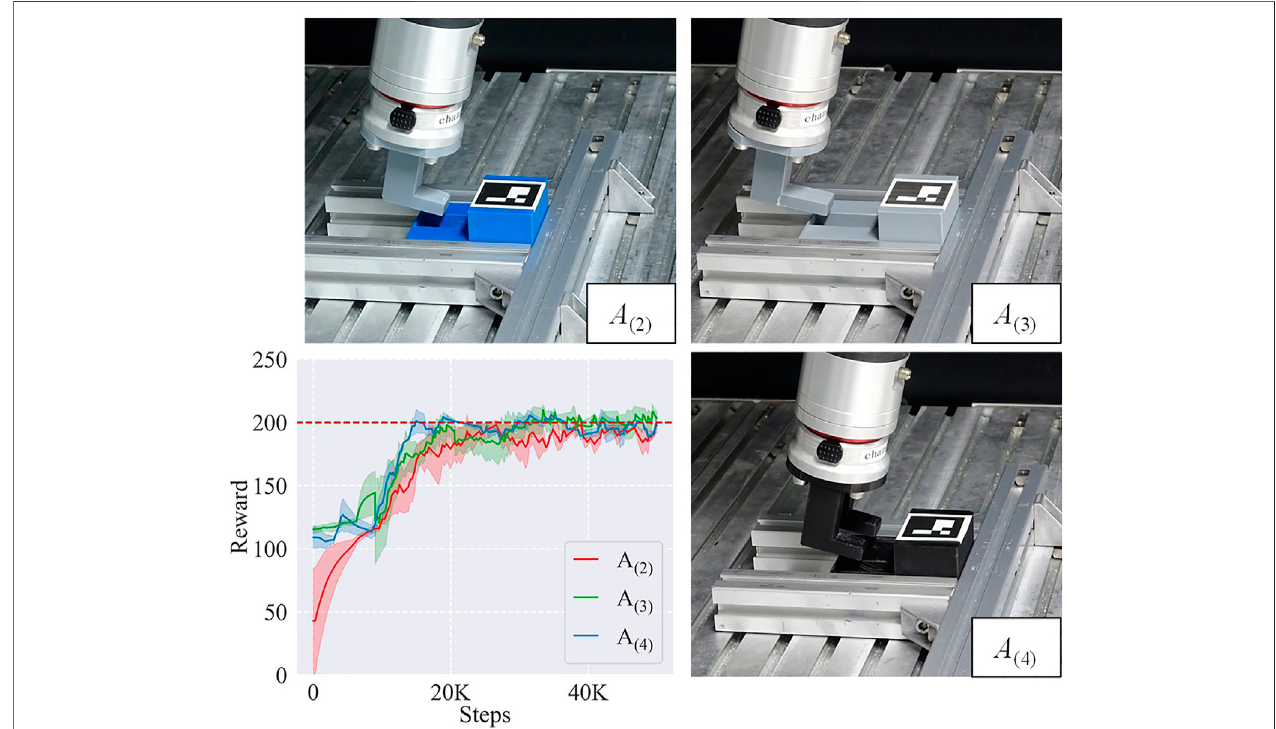
FIGURE 9 | Sim-to-real tasks A (2) , A (3) , and A (4) and their learning curves. The L objects are directly attached to the robot.